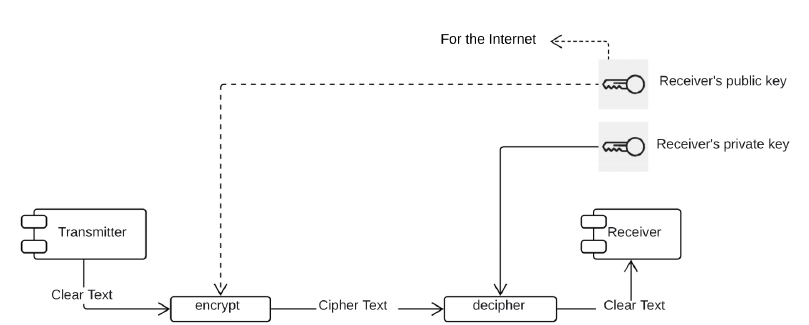
Figure 1. Asymmetric encryption